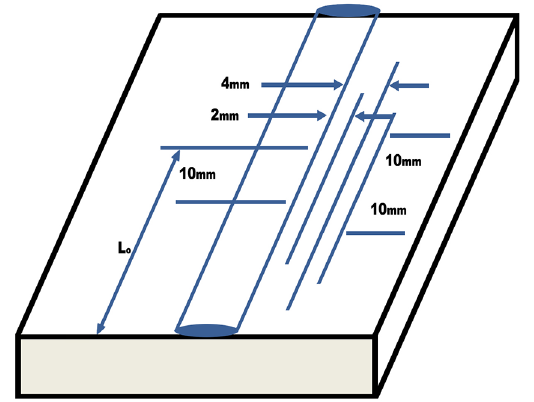
Figure 1 . Schematic diagram of test